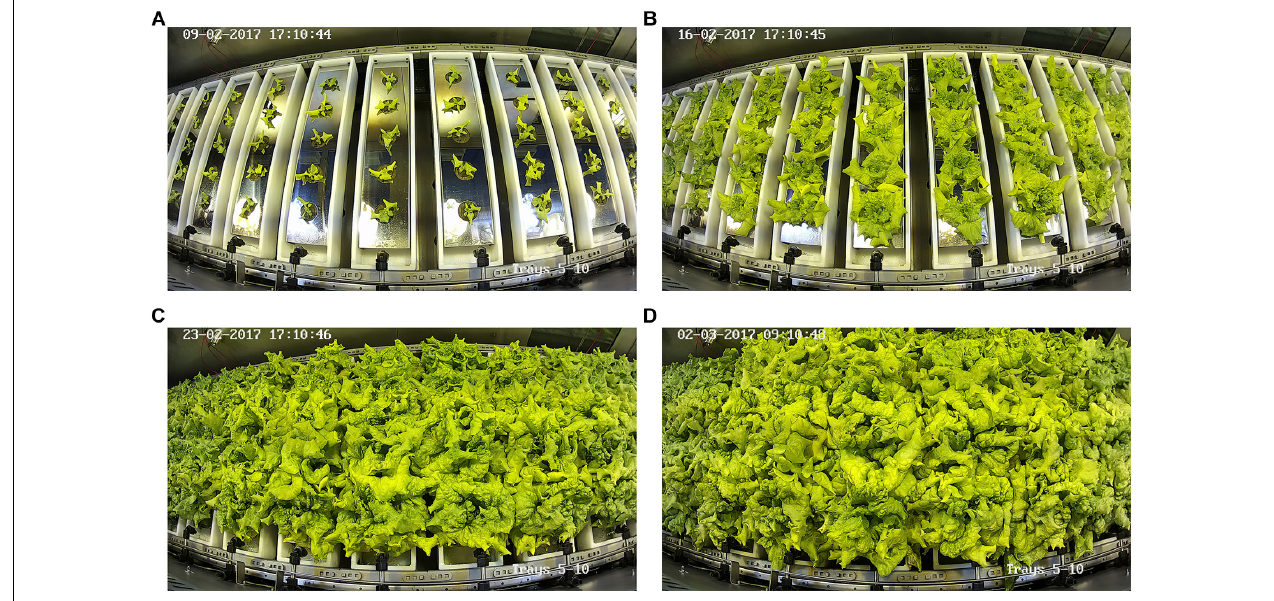
FIGURE 4 | Evolution of lettuce plants growth over the weeks ( A, B, C and D , respectively for 7, 14, 21, and 28 DAT) during Test 2, captured by one of the internal cameras of the HPC.